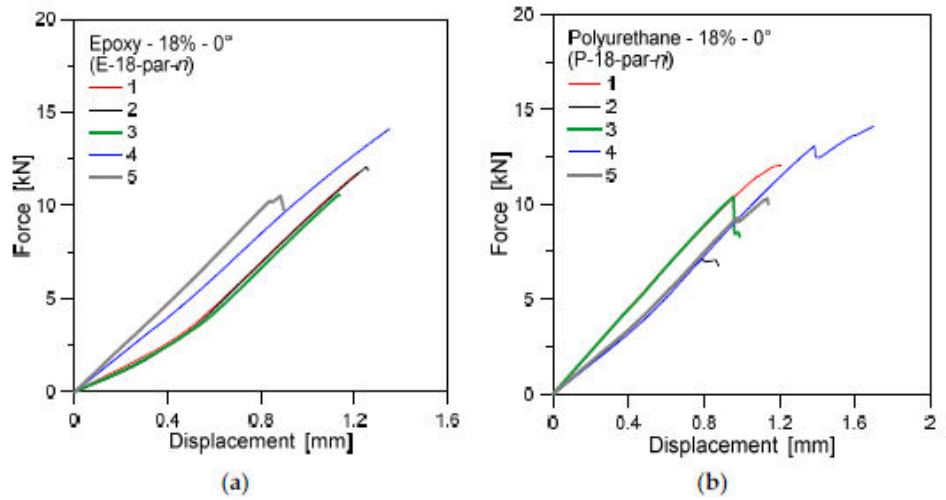
Figure A1. Experimental force–displacement results for specimens with ( a ) epoxy or ( b ) polyurethane glue, under 18% moisture and parallel rod-to-grain arrangement.